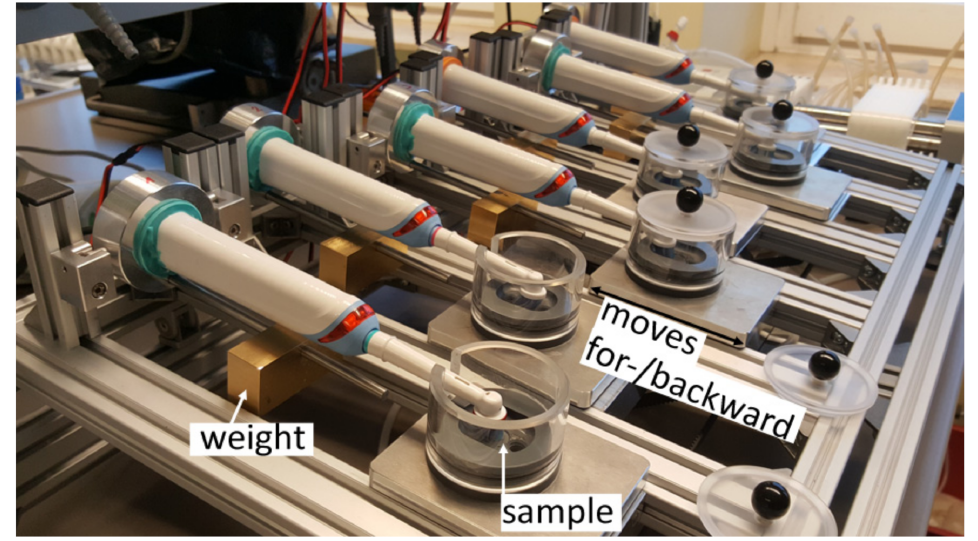
Figure 2. Custom-built automated tooth-brushing machine used in this